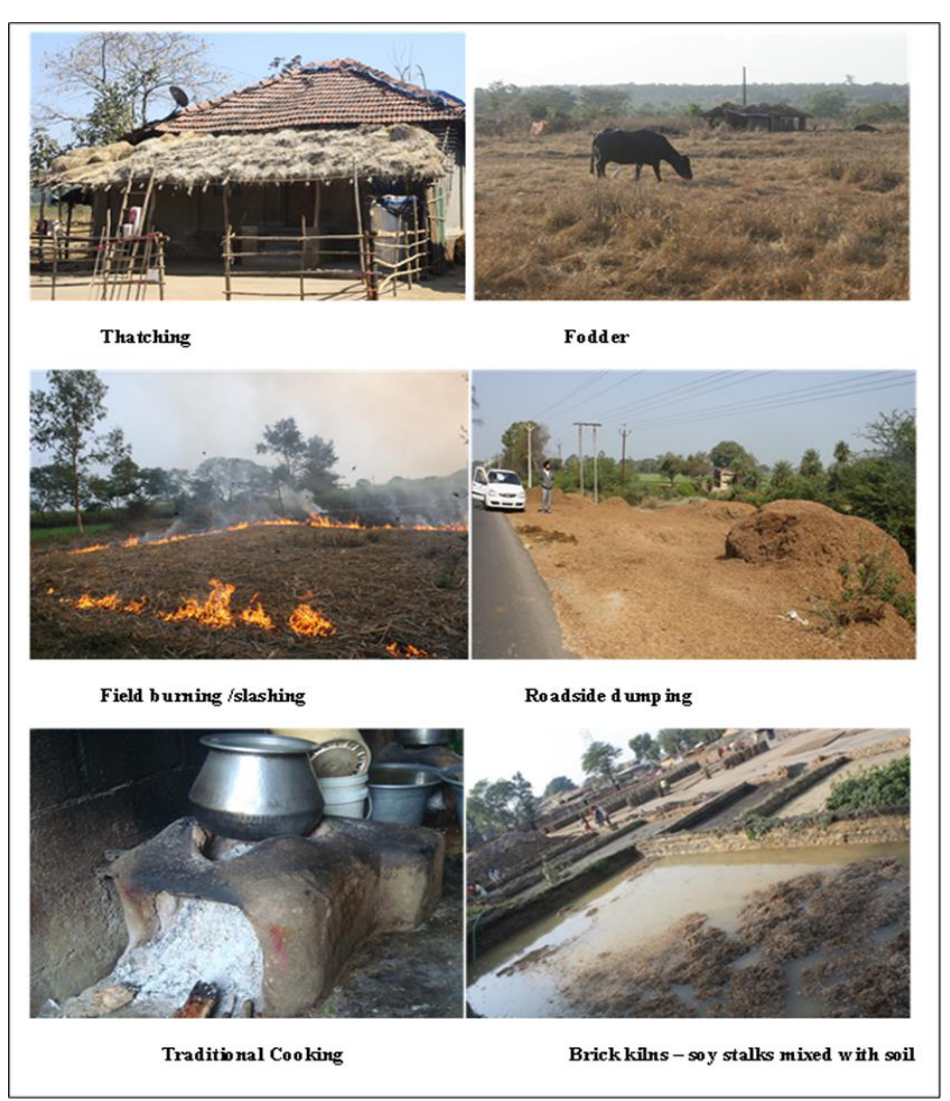
Figure 3. Field-documentation of the various biomass uses in the surveyed